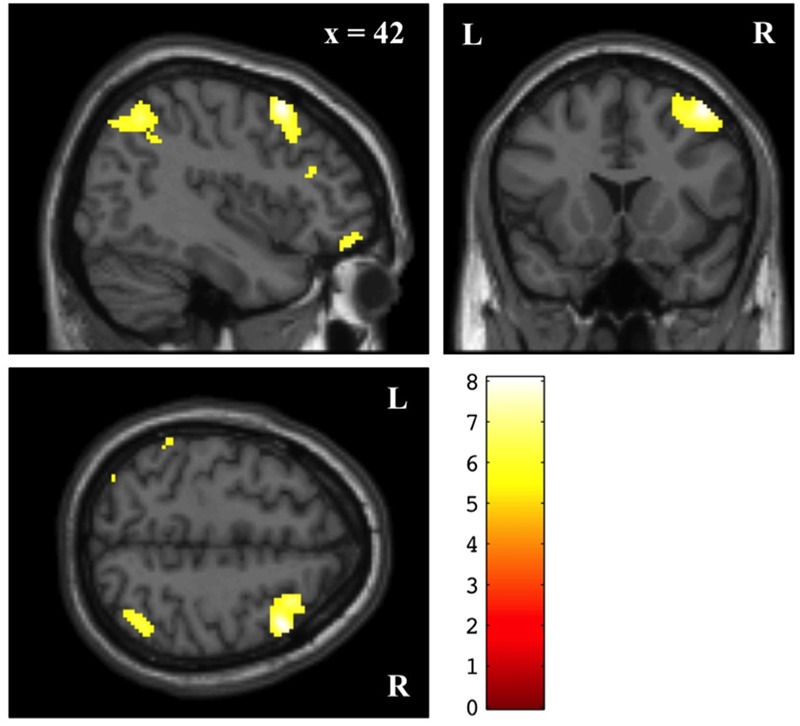
Main effect of prayer (Secular Prayer > Religious Prayer) across naloxone and saline sessions. Voxel-wise statistical parametric maps (pFWE < 0.05) superimposed on SPM canonical anatomical image. See Table 4 for a complete list of foci.